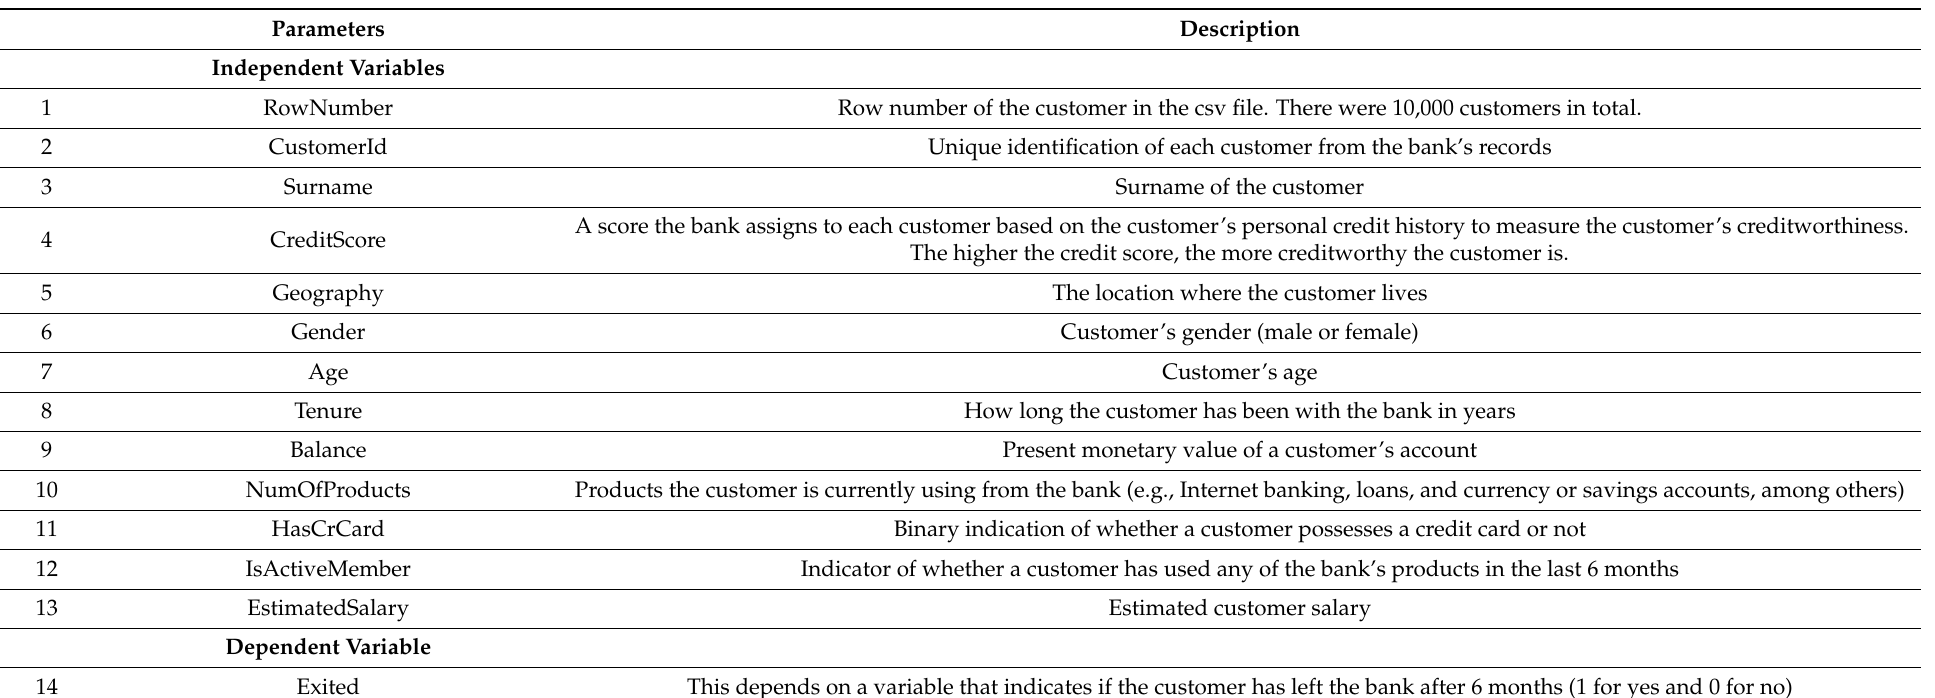
Table 1. Descriptions of the dataset